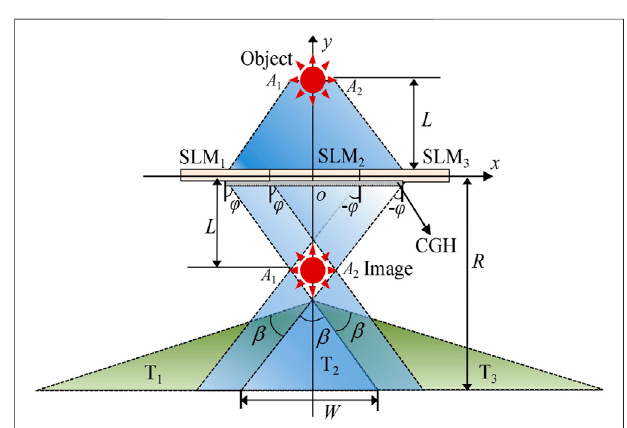
FIGURE 4 | Light distribution of the reconstructed image by the proposed